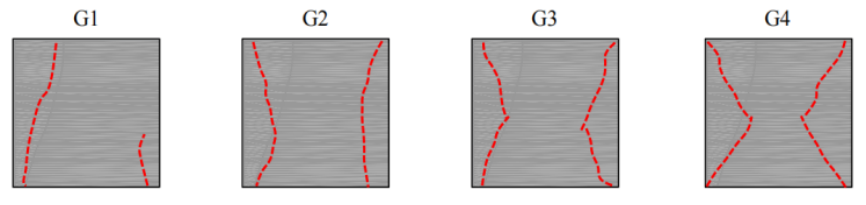
Figure 8. Diagram of similar material damage characteristics.